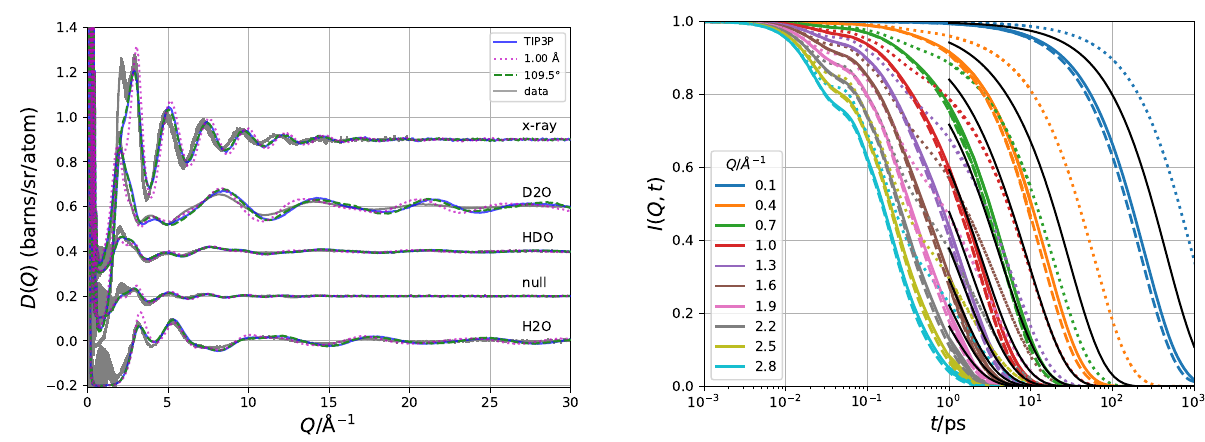
Figure 7. Parameter change in TIP3P rigid: 0.9572Å O–H bond length versus 1.00Å O–H bond length, and 104.25° H–O–H angle versus 109.50° H–O–H angle. Left: di ff ractograms for X-rays and neutrons with four di ff erent isotopic substitutions for each of the parameter changes as well as data [36] with di ff erent o ff sets for better visibility respectively. Right: intermediate scattering functions, black solid lines refer to literature data [37], solid colored lines refer to the standard TIP3P with a 104.25° angle and a 0.9572Å bond length, dotted lines to a 1.00Å bond length, and dashed lines refer to a 109.50°